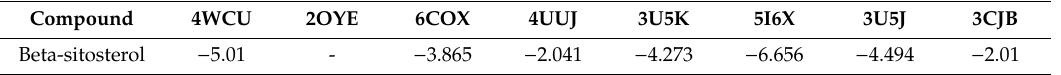
Table 7. Molecular docking score of beta-sitosterol isolated from B. pilosa